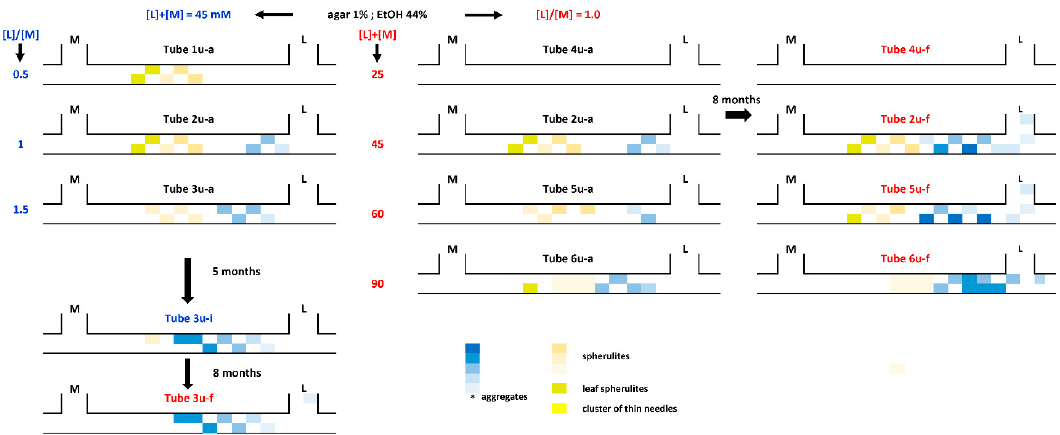
Figure 8. Results of the crystallization screening in water-EtOH 44% v / v performed by double diffusion in a U-tube for the CdCl 2 -bpp system. The schemes refer to a growth period of five weeks. The effect of [L] + [M] and [L]/[M] is shown at constant solvent composition and gel density with fixed boundary conditions (U-tube size, total volume). The month-scale time evolution of the crystallization trials is also reported, to highlight the long time required to reach